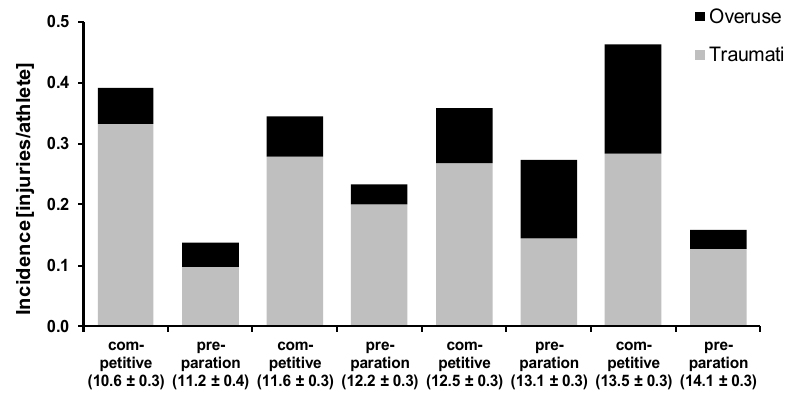
Figure 1. Incidence of traumatic (gray) and overuse (black) injuries per athlete by test time point.